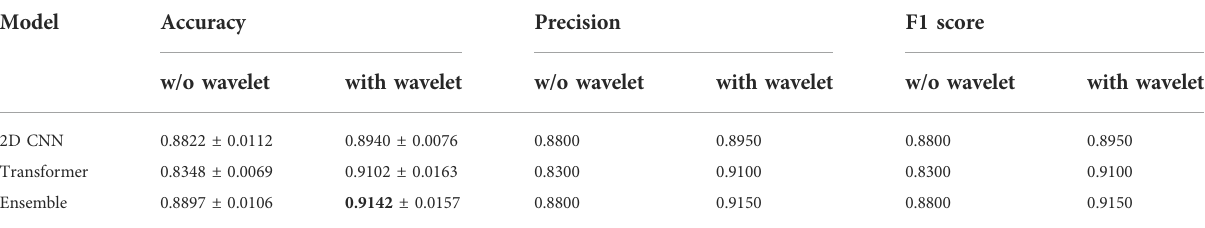
TABLE 2 Performance of the two models and their ensemble on the presence of haptic delay dataset (two classes).The reported fi gures are the mean and standard deviation for 5-fold cross validation obtained on the test set.